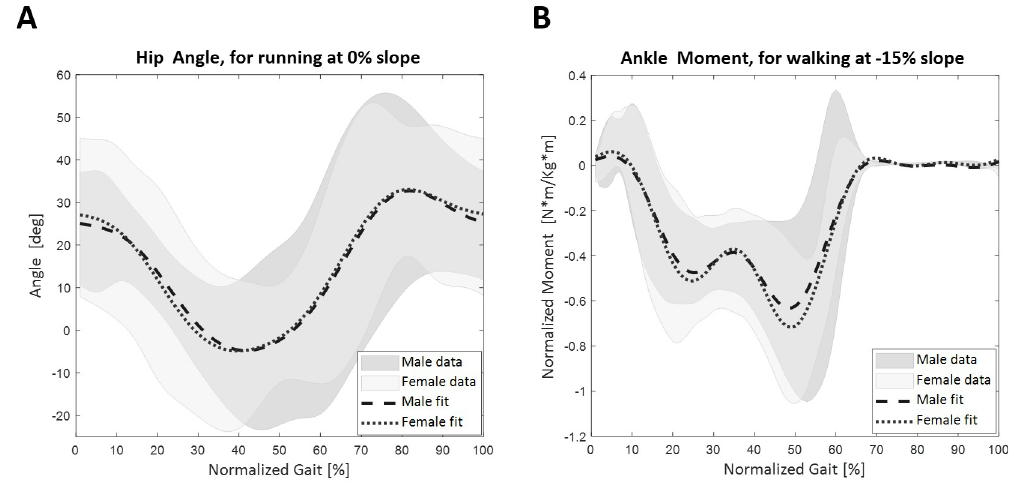
Fig 9. Examples and data distributions of the two models for each gender (male and female), with the dark and light gray shading represent averaged signal ± 3 standard deviations for male and female participants, respectively. A: Data and fit of the hip angle in the sagittal plane while running at 2.25m/s at a 0% slope. B: Data and fit of the ankle moment in the sagittal plane while walking at 1.25m/s at a -15% slope.